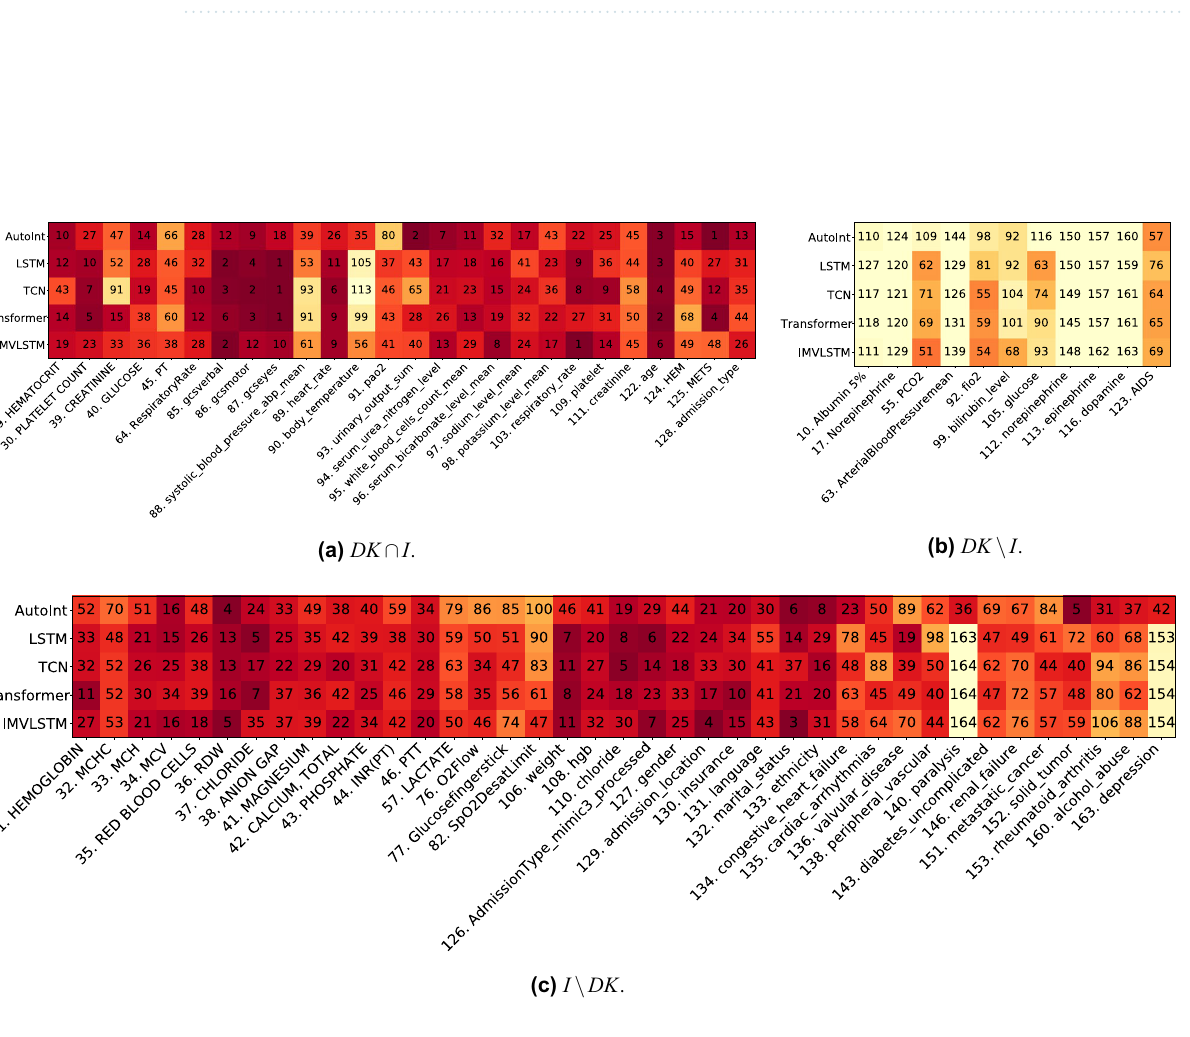
Figure 3. Visualization of global feature importance ranks for the overlapping and non-overlapping features between domain knowledge ( DK ) and interpretation results ( I